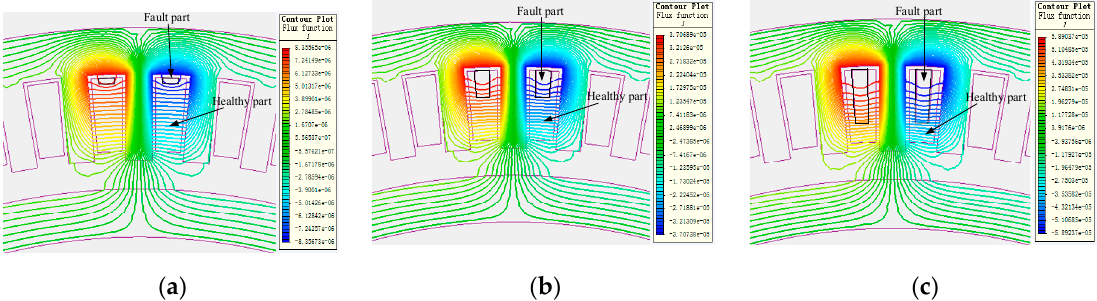
Figure 13. The flux density distributions when the fault with different shorted turns is located on